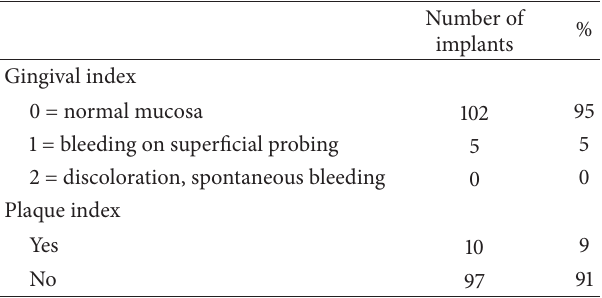
Table 3: Soft tissue scores after 7-8 years.